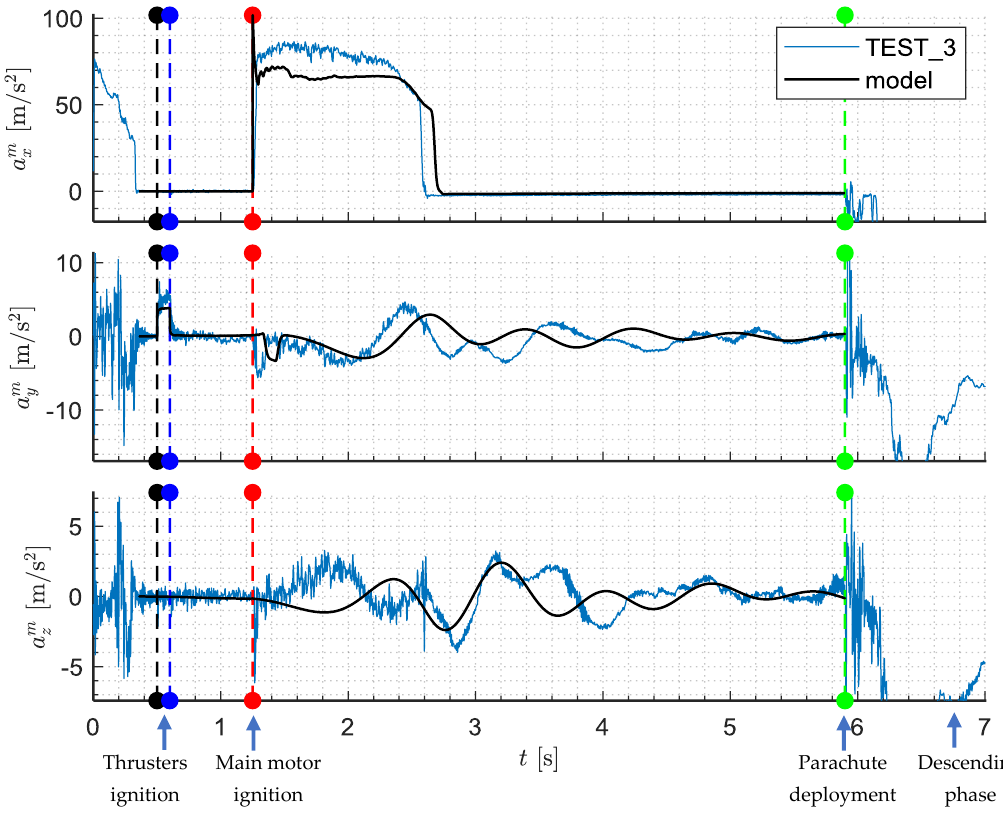
Figure 23. Accelerations (test 3, lateral thrusters before the center of mass).